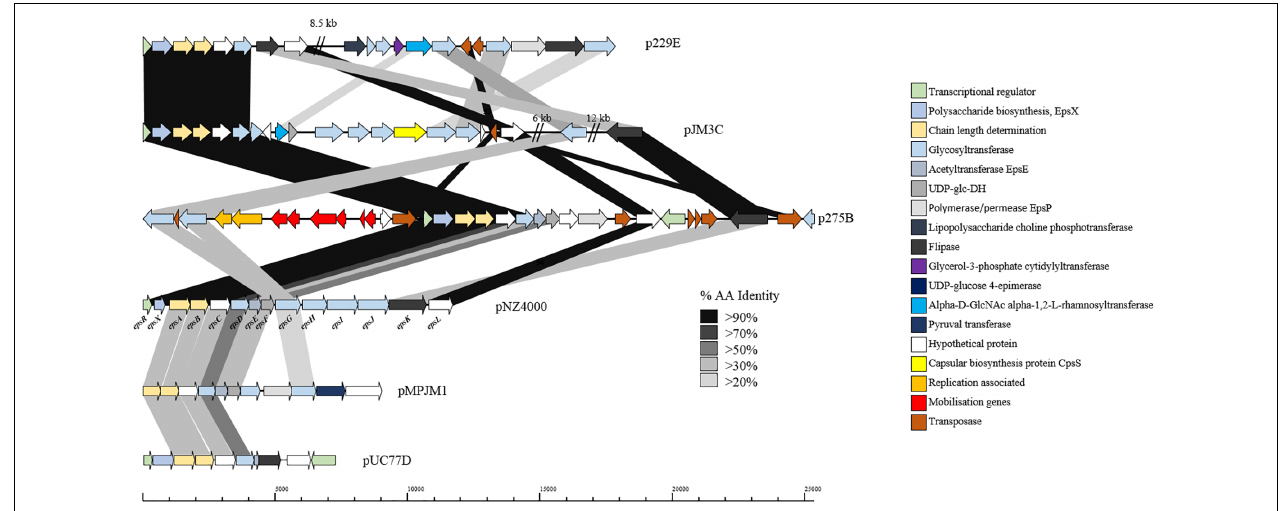
FIGURE 6 | Linear BLAST map of the lactococcal EPS gene clusters. Linear BLAST map of eps gene clusters from (1) p229E, (2) pJM3C, (3) p275B, (4) pNZ4000, (5) pMPJM1, and (6) pUC77D. Arrow color indicates predicted product, while shaded region indicated percentage amino acid identity between BLAST hits. The highly conserved region of the gene cluster is apparent from EpsR to EpsD while the variable region is strain